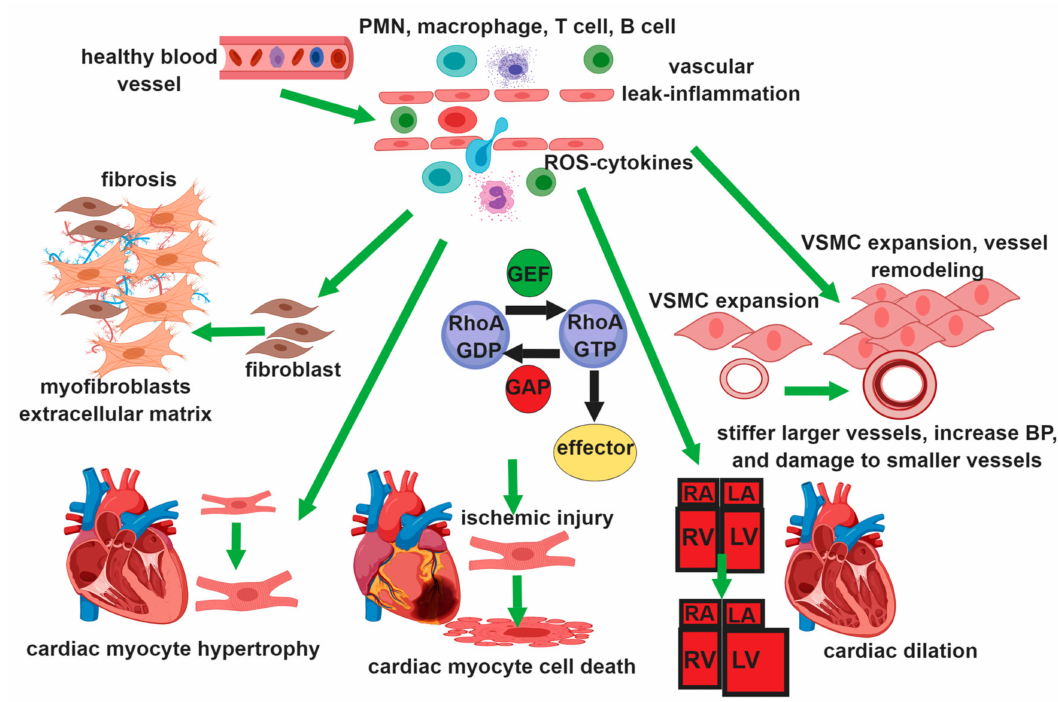
Figure 2. RhoGTPase function in di ff erent vascular cells: In the endothelium activation of RhoA, Rac1 control barrier function, leukocyte chemotaxis, ROS production, and inflammation. In smooth muscle cells, RhoA regulates Vascular Smooth Muscle Cell (VSMC) contraction, proliferation, migration, and di ff erentiation. In fibroblasts, RhoA promotes the transformation of fibroblasts to myofibroblasts and increased extracellular matrix production contributing to vascular fibrosis and interstitial fibrosis in the heart and the lung. In the heart, RhoA activity is associated with myocyte hypertrophy, and with apoptosis in ischemic